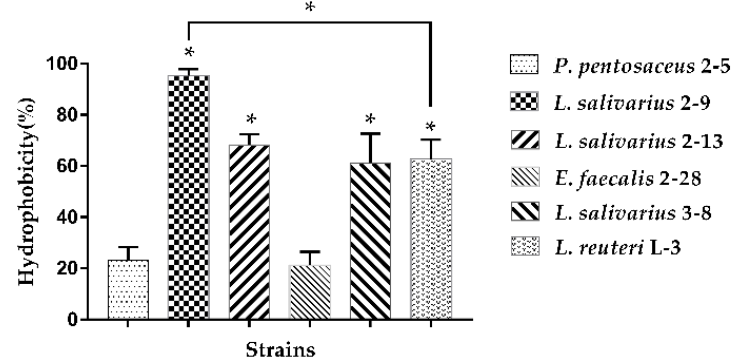
Figure 1. Hydrophobicity of strains determined after 2 h of incubation with xylene. The results represent the mean ± SD of three independent experiments. The significant difference was indicated by asterisks compared to P. pentosaceus 2-5: * p <0.05.